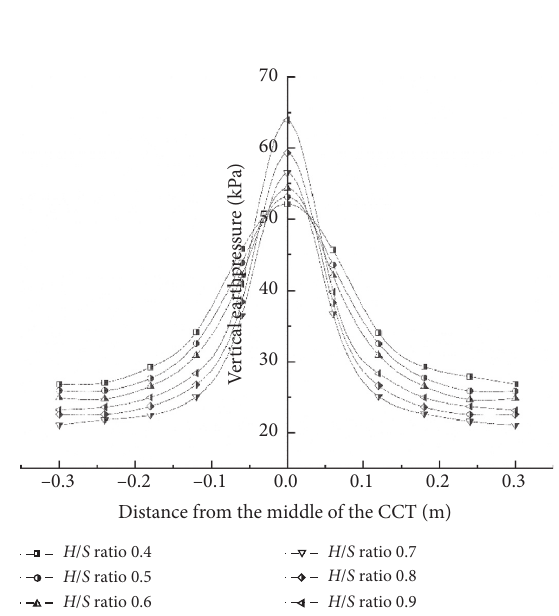
Figure 4: Variation of vertical eearth pressure for case S1 on top of CCT.